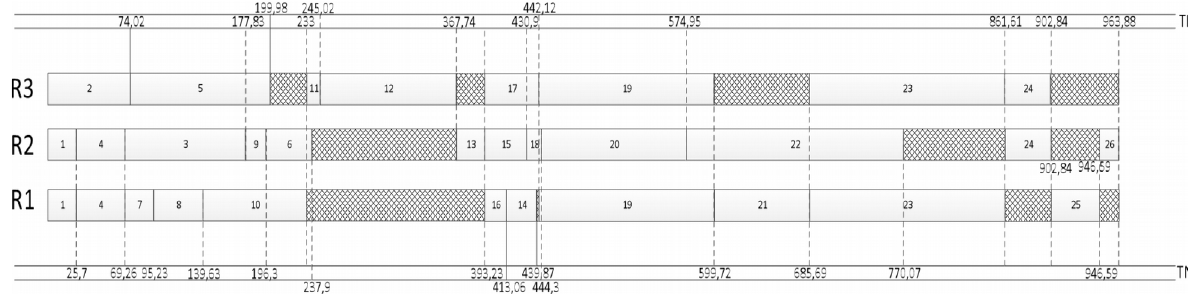
Figure 13. Gantt Chart for the ACTIM, ACTRES, dan TIMRES Scheduling (Scenario 4)